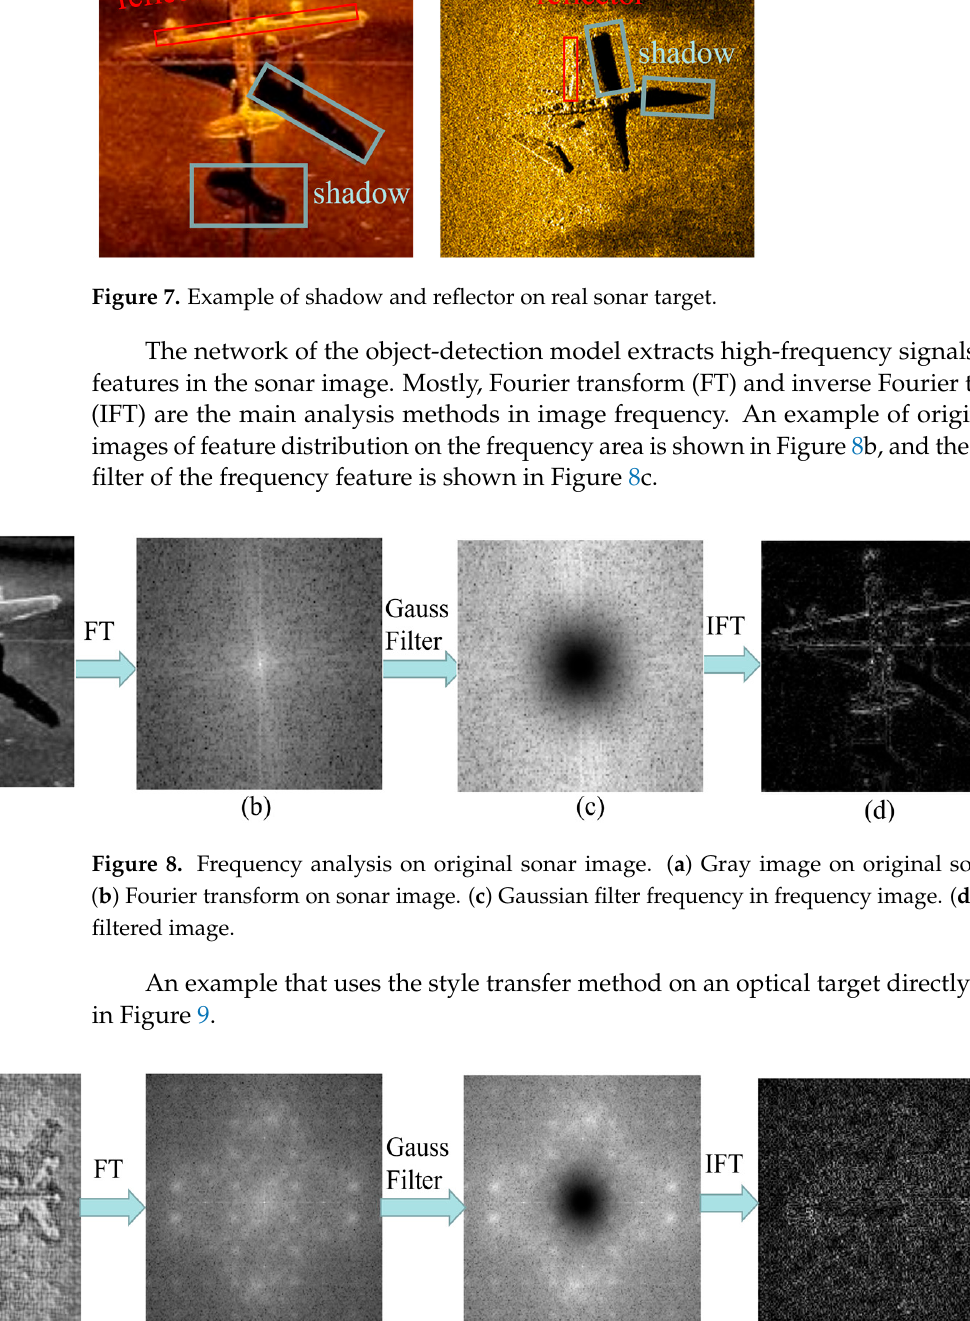
6 of 18 Figure 6. Original sonar image with optical target transfer to sonar style target. ( a ) Original sonar image. ( b ) Optical image. ( c ) Traditional style transfer image. ( d ) Feature enhancement style trans ‐ fer image. Generally, style transfer can be described as being in two steps. First, the style transfer network via style image and content images generate a style model. Secondly, we input